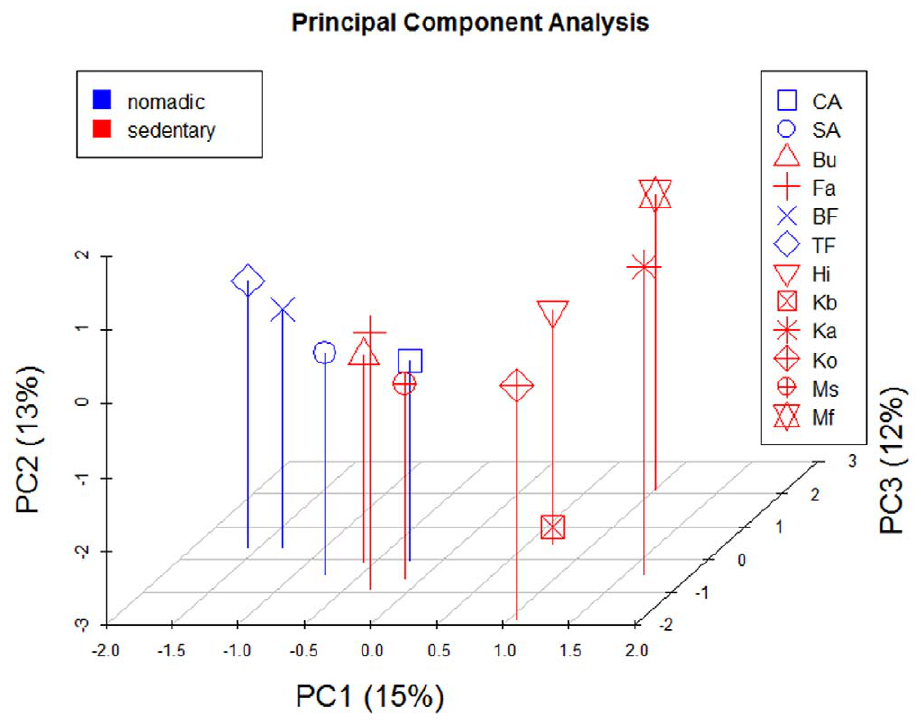
Figure 3. PC plot of ethnic relationships based on hg frequencies. Percentage values in brackets refer to the amount of variation accounted by the first three principal components (PC1, PC2, and PC3). Codes for populations are as indicated in Table 1. Nomadic populations are plotted in blue while sedentary ones are plotted in red.